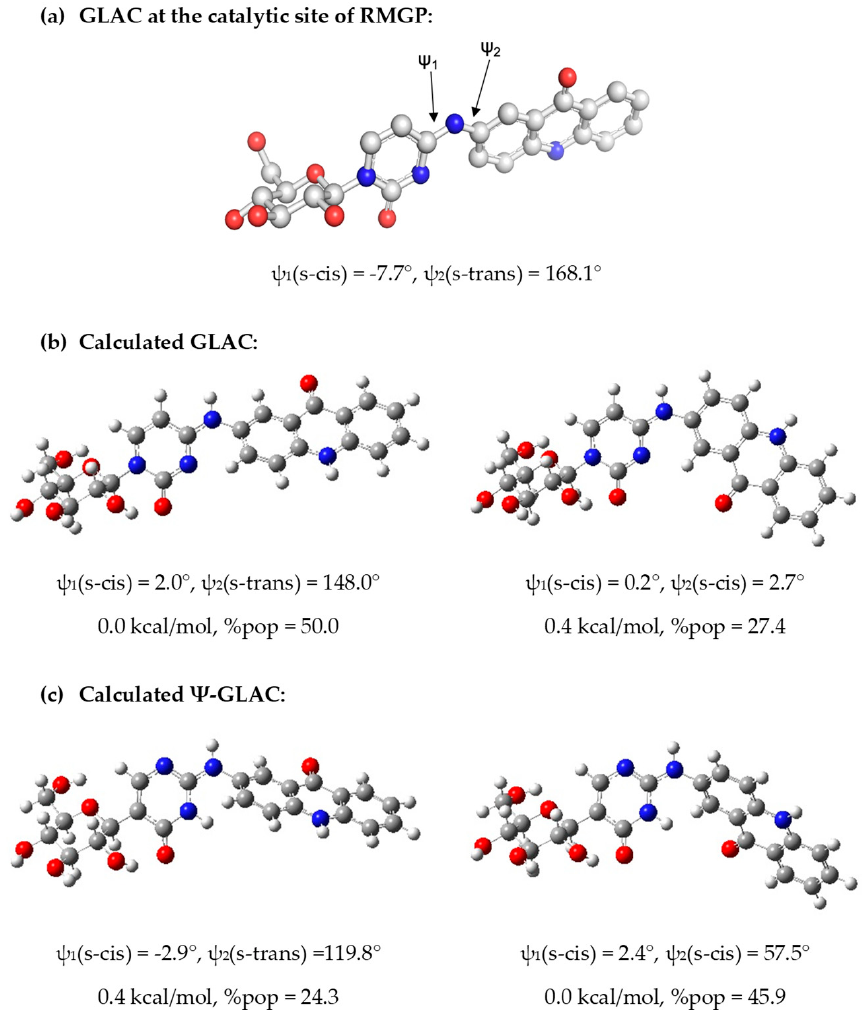
Figure 5. ( a ) Conformation of GLAC within the catalytic site of RMGP. ( b ) The top two lower-energy conformations calculated for GLAC in a polar aqueous environment. ( c ) The top two lower-energy conformations calculated for Ψ -GLAC in a polar aqueous environment.